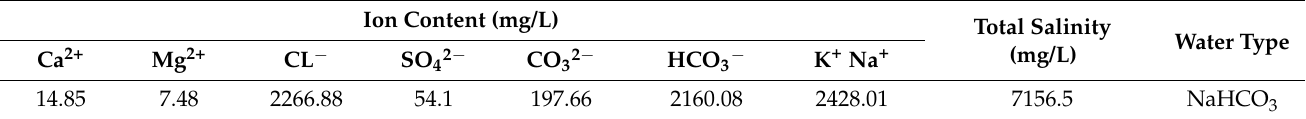
Table 1. Simulated formation water component